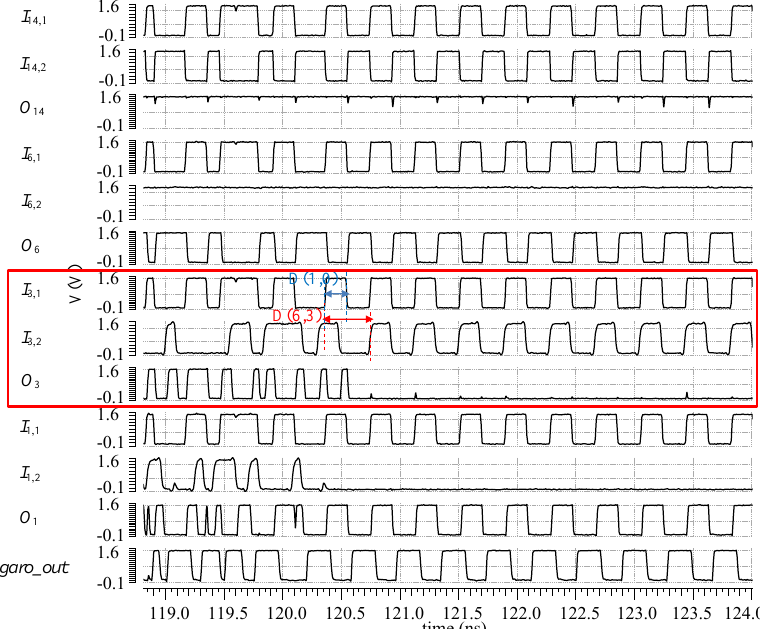
Figure 14: The simulated waveforms with feedback polynomial f ( x ) = x 15 + x 14 + x 6 + x 3 + x +